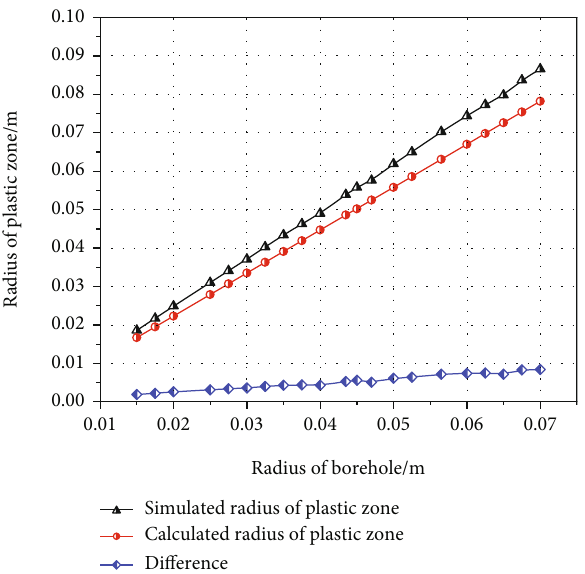
Figure 7: Comparison of the plastic zone radius.